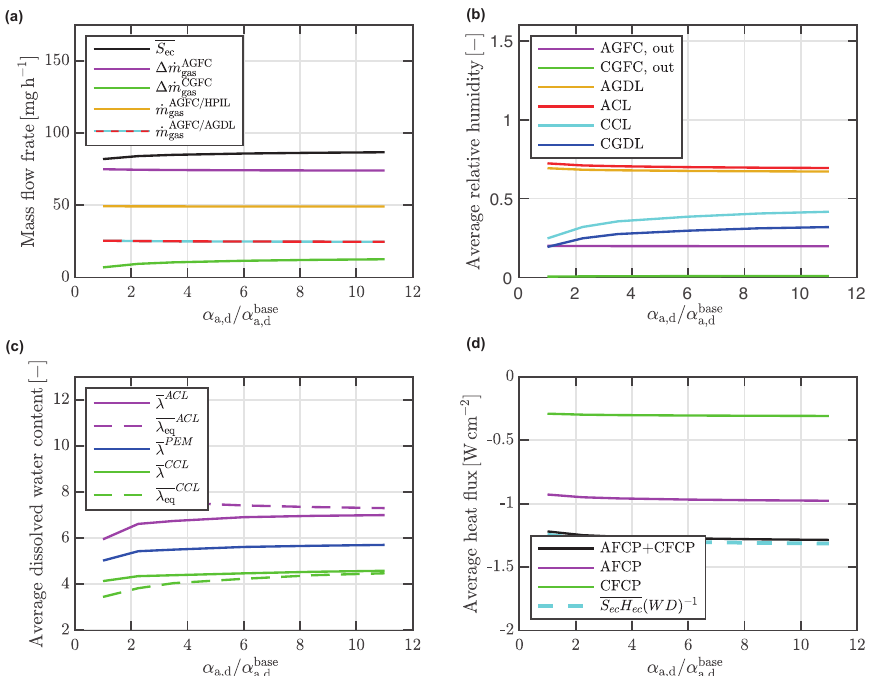
Figure 9. Key output parameters as defined in Table A5 as a function of the mass transfer coefficient for ab-/desorption by multiplying it by a factor α a,d / α base terization (Equation (49)): ( a ) integrated evaporation rate and mass flux leaving the cell via the AGFC/CGFC and entering the AGFC via the interfaces with the HPIL and AGDL, respectively; ( b ) average relative humidity in different domains and at the gas channel outlets; ( c ) average dis- solved water content and equilibrium hydration number; and ( d ) average heat flux across the anode and cathode FCP